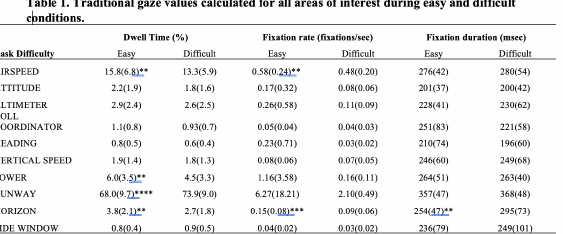
Figure 2. Individual data points and their respective group means for success rate (%) (A), completion time (sec) (B), and overall performance scores (C) are demonstrated for easy and difficult conditions. Error bars represent SEM. *p≤0.05, **p≤0.01, ***p≤0.001, ****p≤0.0001.